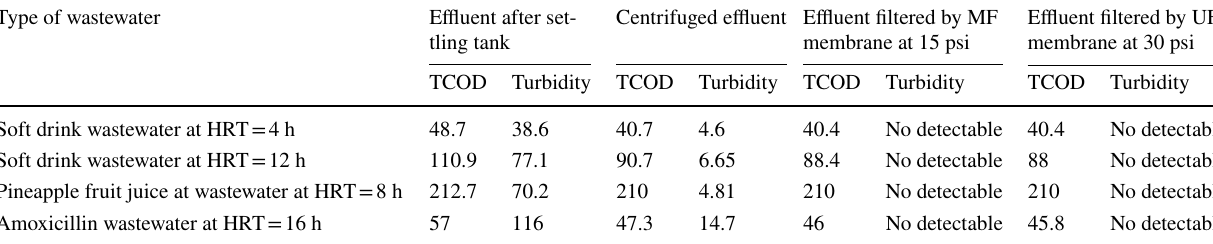
Table 4 COD and turbidity in the different conditions for the optimal runs Type of